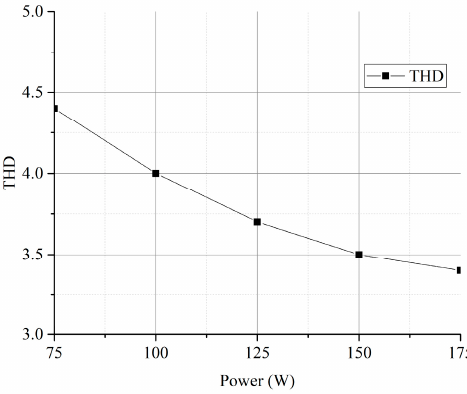
Figure 11. THD evolution through a power sweep.